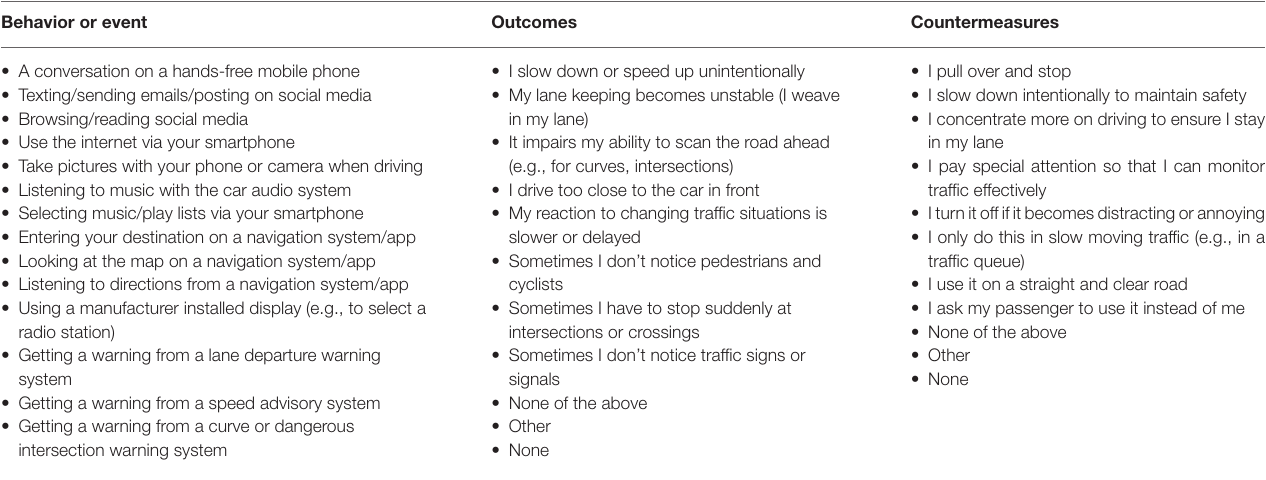
TABLE 2 | The behaviors and events, possible outcomes, and countermeasures used in the online questionnaire. Behavior or